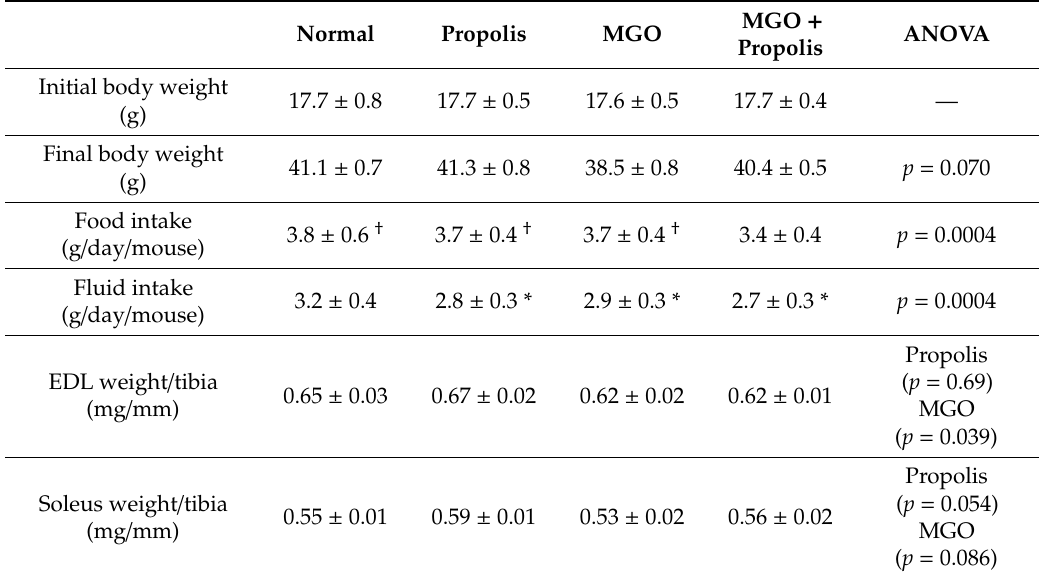
Figure 1. The inhibitory effect of Brazilian propolis used at different concentrations (0, 0.1, 1.0, 10, and 100 mg/mL) on formation of advanced glycation end products (AGEs). Values are means ± SE; n = 4/group. Values are expressed as percent change relative to the value of aminoguanidine. Table 2. Body weight, food intake, fluid intake, and muscle weight.